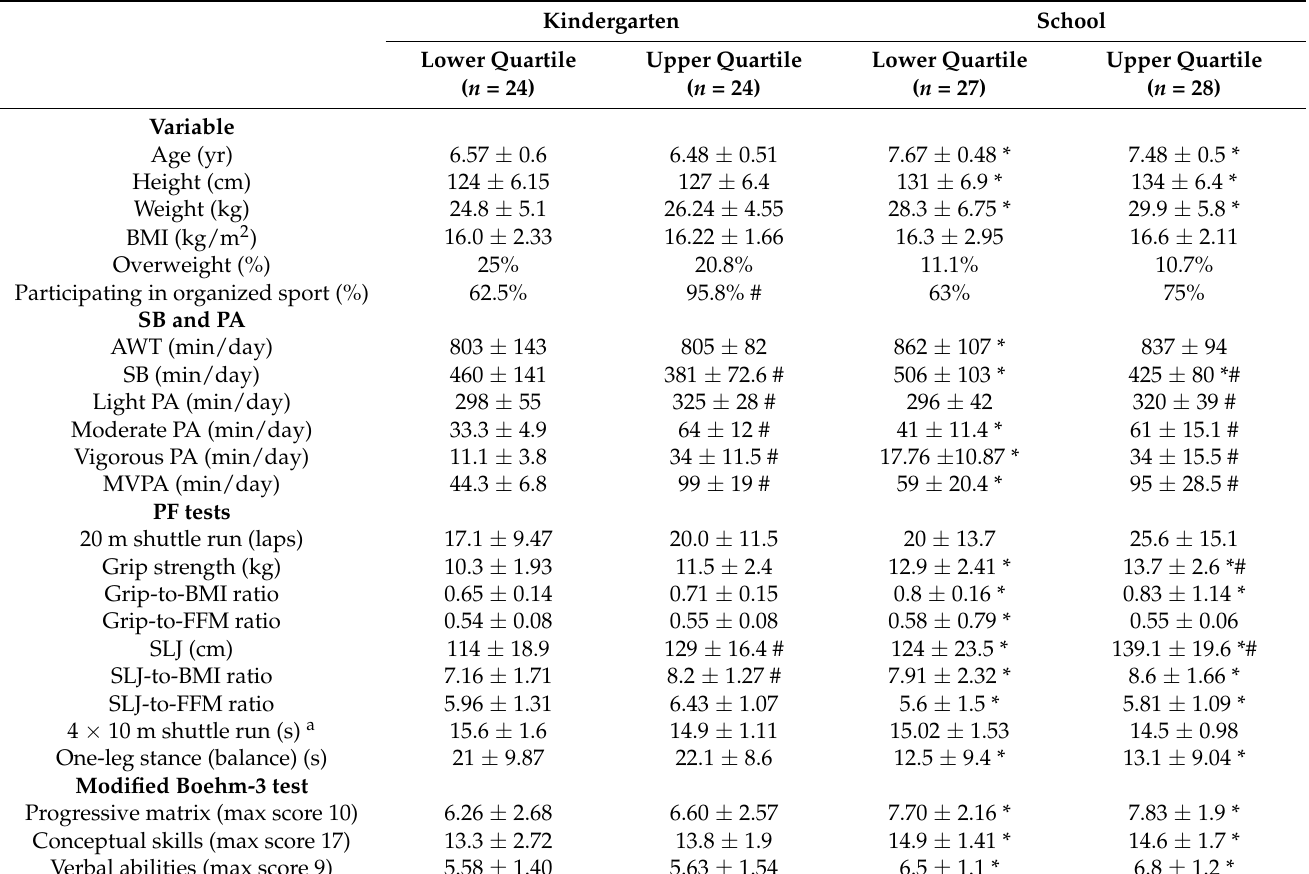
Table 1. Descriptive statistics of study participants at 6.6 years (final year of kindergarten) and at 7.6 years (1st grade at